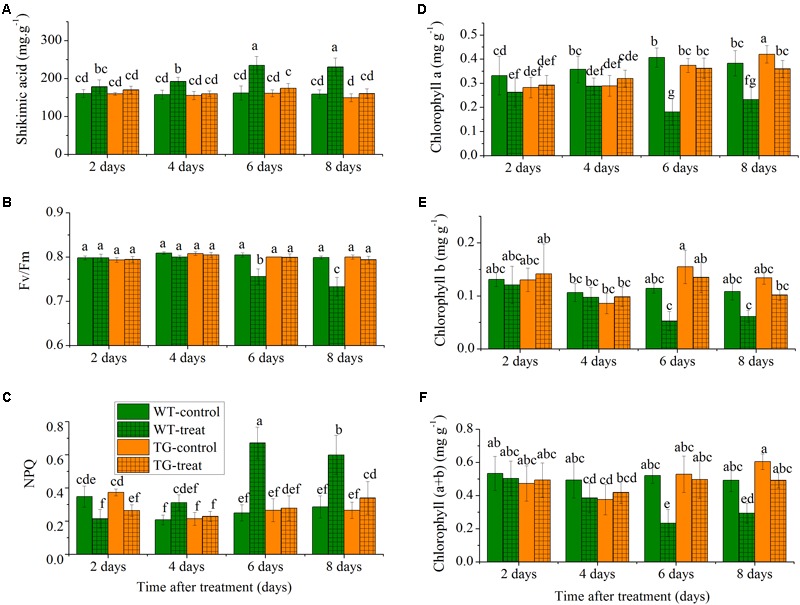
Time-course effect of glyphosate on the responses of leaf shikimic acid concentration (A), Fv/Fm
(B), NPQ
(C), chlorophyll a (D), chlorophyll b (E), and chlorophyll (a+b) content (F) in WT and TG maize plants. Values are presented as the means plus error bars, where the error bars represent the SD of the mean. Within a graph, any two bars with a common letter are not statistically significant (P > 0.05).